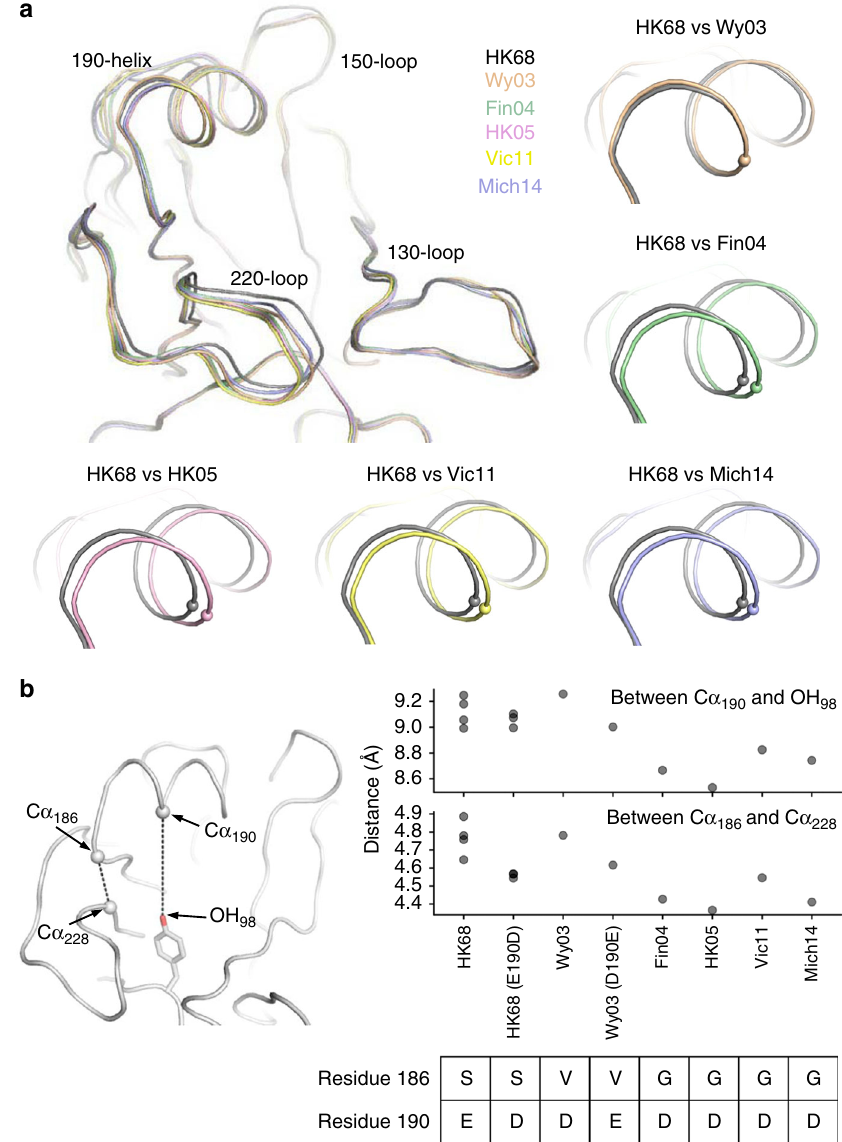
Fig. 4 Structure comparison of HA RBS from different strains. a The HA RBS conformations of HK68 E190D (gray), Wy03 (orange), Fin04 (green), HK05 (pink), Bris07 (blue), and Vic11 (yellow) were compared by aligning their receptor-binding subdomain (HA1 residues 117 – 265) 24 . Pairwise comparisons of the 190-helix region are also shown. C α of residue 190 for each HA is shown in a sphere representation. b The distances between the C α of residues 186 (C α 186 ) and the C α of residues 228 (C α 228 ) and between the C α of residues 190 (C α 190 ) and the phenolic oxygen of residue 98 (OH 98 ) in different strains were measured. HK68: PDB 4FNK (ref. 59 ) and PDB 4WE4 (ref. 66 ). Fin04: PDB 2YP2 (ref. 9 ). HK05: PDB 2YP7 (ref. 9 ). Vic11: PDB 4O5N (ref. 23